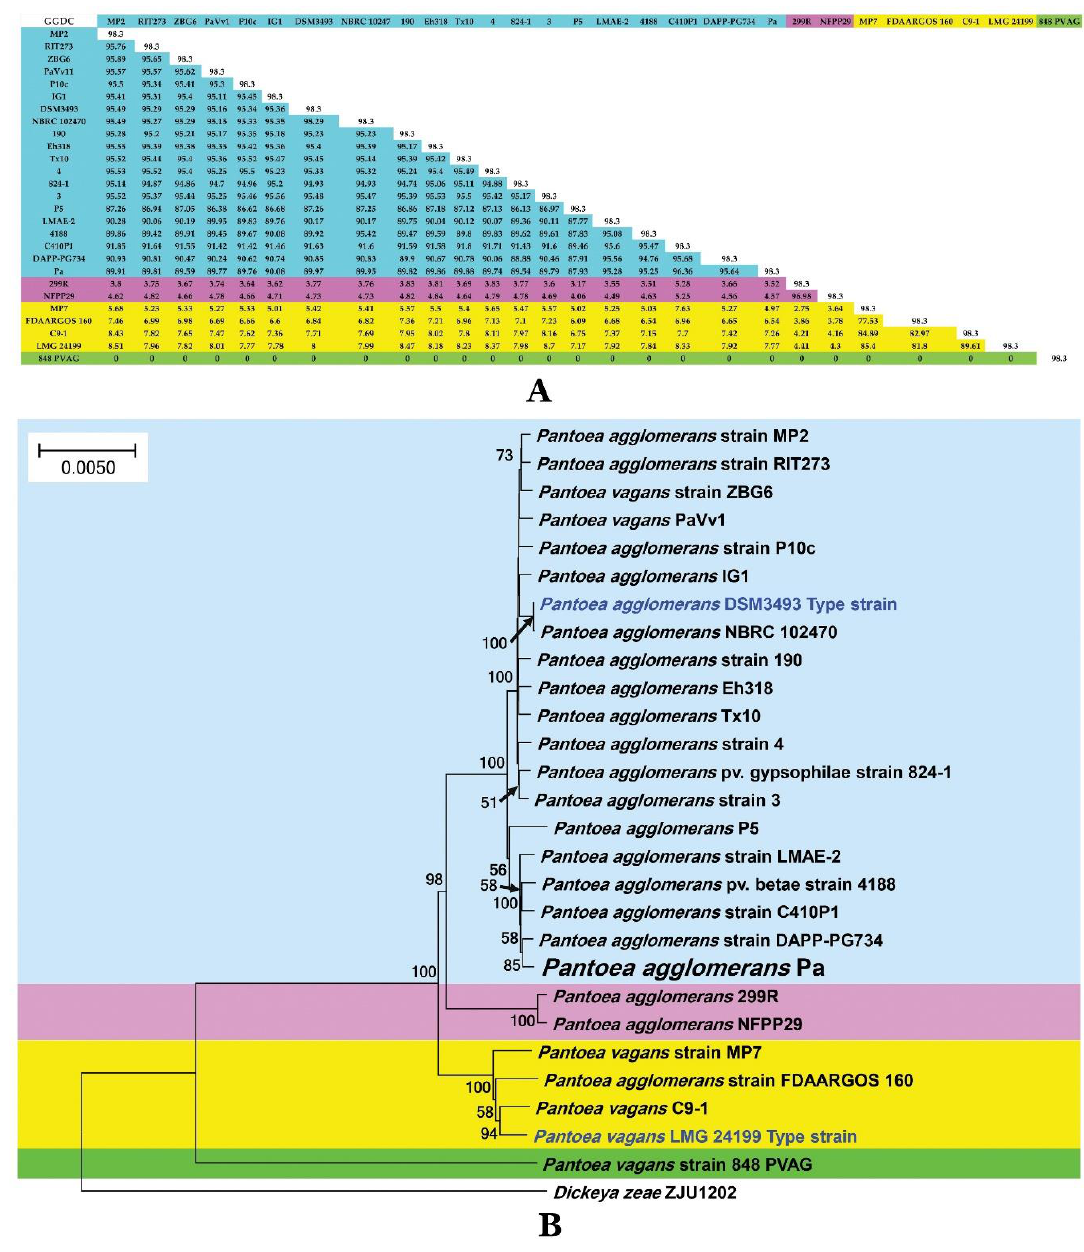
Figure 9. Taxonomy of P. agglomerans Pa isolate and its phylogenetic position within fully-sequenced of P. vagans and P. agglomerans isolates publicly available in GenBank database. ( A ) Genome-to-Genome Distance Calculation (GGDC) values between each indicated strain were calculated with GGDC 2 web-based program, showing four species candidates based on 70% similarity thresholds. ( B ) Maximum Likelihood phylogenomic tree of Gram-negative bacteria P. agglomerans and P. vagans strains. Dickeya zeae strain ZJU1202 was used as outgroup. Bar, number of expected changes per